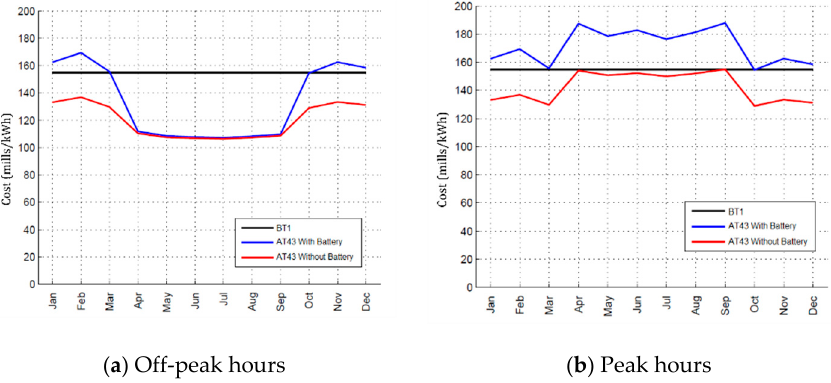
ff -peak hours and peak hours’ consumption.